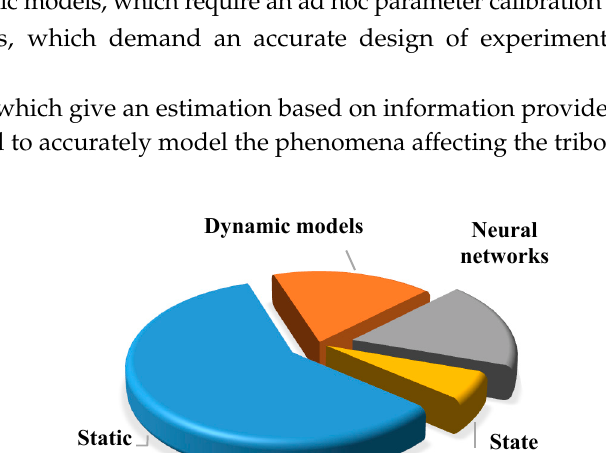
Figure 1. Pie chart arising of the state of art of techniques for the estimation of the BLCF.